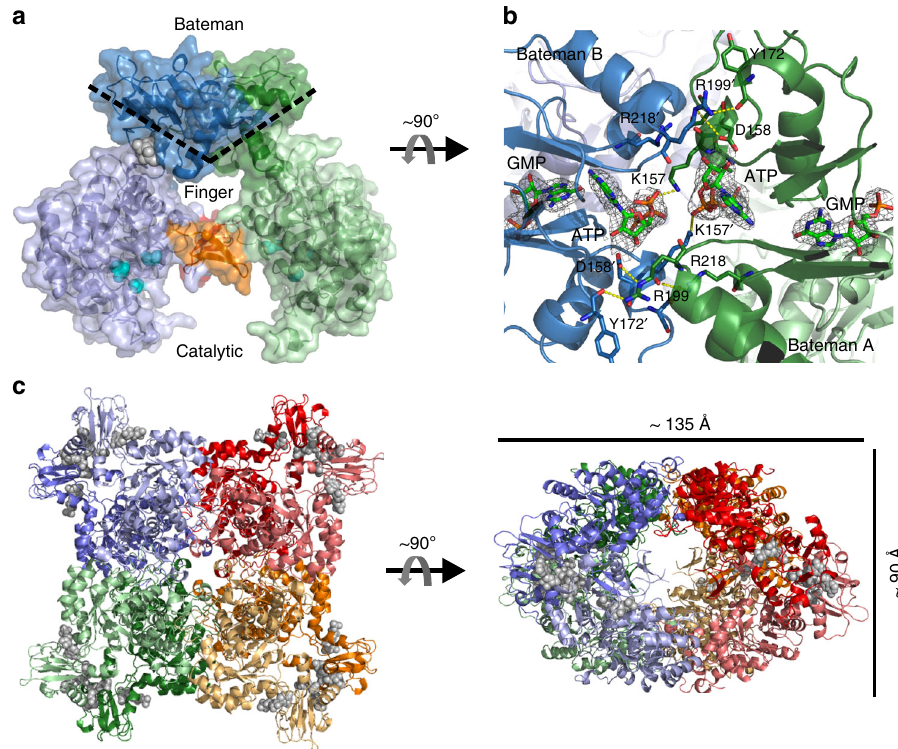
Fig. 7 Quaternary structure of TbIMPDH-ATP1/GMP2. a Relative orientation of two TbIMPDH monomers located in the ASU, estimated by the approximate angle spanned by the two beta sheets of the CBS motifs in each Bateman domain, as indicated by the dashed line. The fi nger domains are highlighted (orange/red), the catalytic residues (cyan), and the bound nucleotides (gray) are shown as spheres. b Detailed view on the interface formed by the adjacent Bateman domains (green/blue, cartoon representation) within the TbIMPDH dimer. Residues involved in the dimer interaction (yellow dashes) and ATP/GMP molecules are shown as sticks. The displayed 2F o F c -electron density of ATP and GMP is countered at 1.0 sigma. c Cartoon representation of the octamer assembly of TbIMPDH monomers, as observed within the in cellulo crystals and corresponding space group, in different views rotated by 90°. Four dimers are forming an octamer around the 4-fold symmetry axis. The dimeric building blocks observed within the ASU are individually colored. Bound nucleotides are shown in a gray spheres